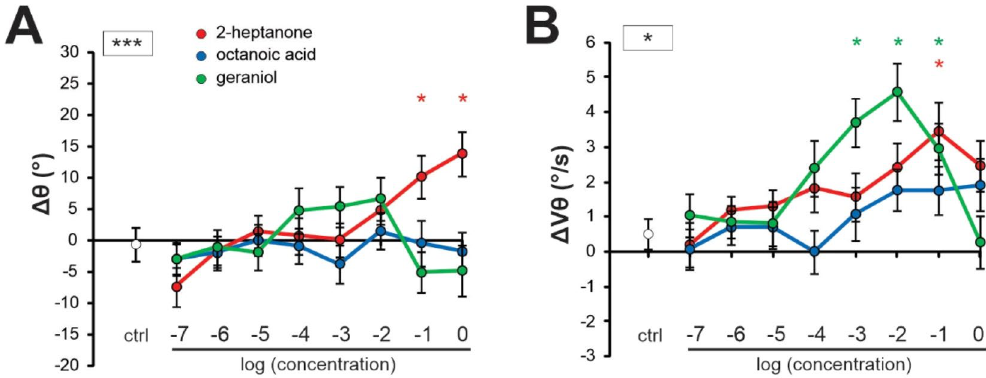
Figure 5. Influence of odorant concentration on antennal movements. ( A,B ) Curves showing the change in ( A ) antennal angular position (Δθ) and ( B ) velocity (ΔVθ) in response to increasing concentrations (from 10 –7 to 10 0 ) of three odorants diluted in mineral oil (N = 43). Ctrl: average response to 4 control stimuli. Asterisks in the square next to the graph indicate significant interactions between stimulus and concentration (RM-ANOVA, *: p < 0.05; ***: p < 0.001). Asterisks on the graph indicate significant differences in Dunnett post hoc tests comparing each concentration to the control (*: p < 0.05, red: 2-heptanone, green: geraniol).